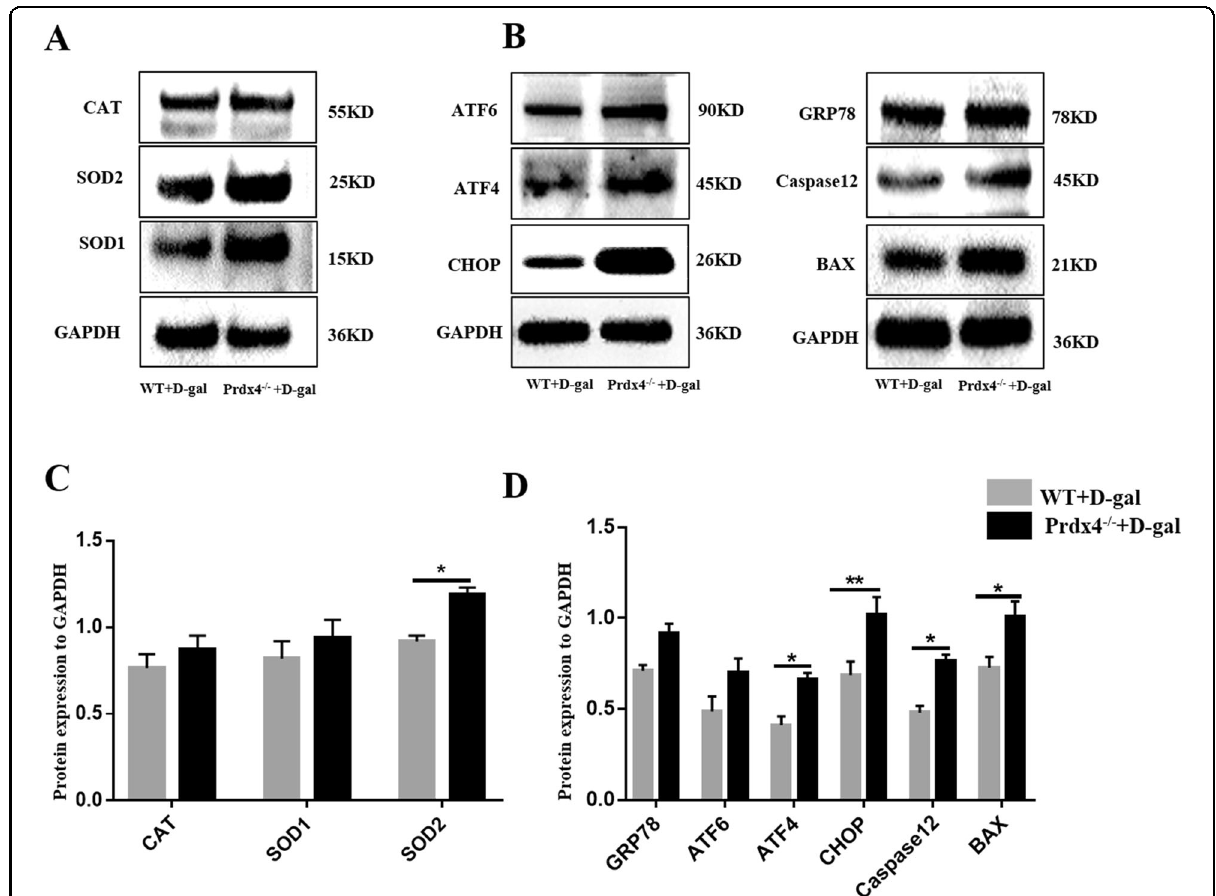
Fig. 5 The expression of compensatory antioxidant enzymes and ER stress pathway-associated factors in the ovary. a The CAT, SOD1 and SOD2 protein expression levels were measured by western blotting. b The levels of ER stress pathway-related factors (GRP78, ATF6, ATF4, CHOP, and caspase-12) and induced expression of the apoptotic protein BAX in ovarian tissues were evaluated using western blotting. c The CAT, SOD1, and SOD2 protein expression levels were quantitatively analysed. d The GRP78, ATF6, ATF4, CHOP, caspase-12, and BAX protein expression levels were quantitatively analysed. All data are shown as means ± SEMs, n = 5. Statistical signi fi cance: * P < 0.05, ** P <